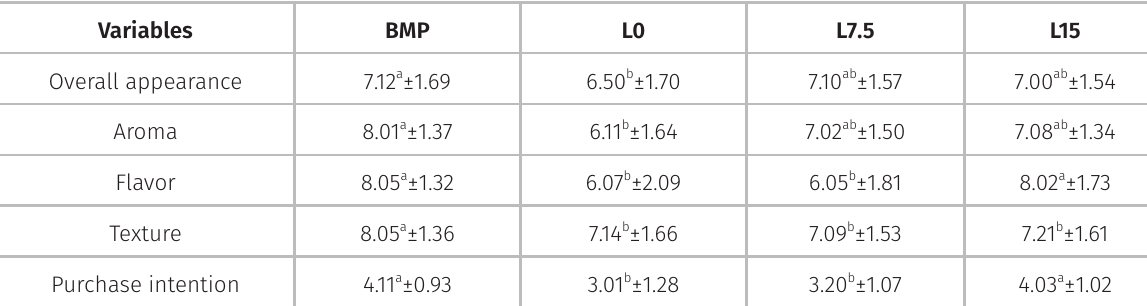
Table V. Sensory results of meat patty